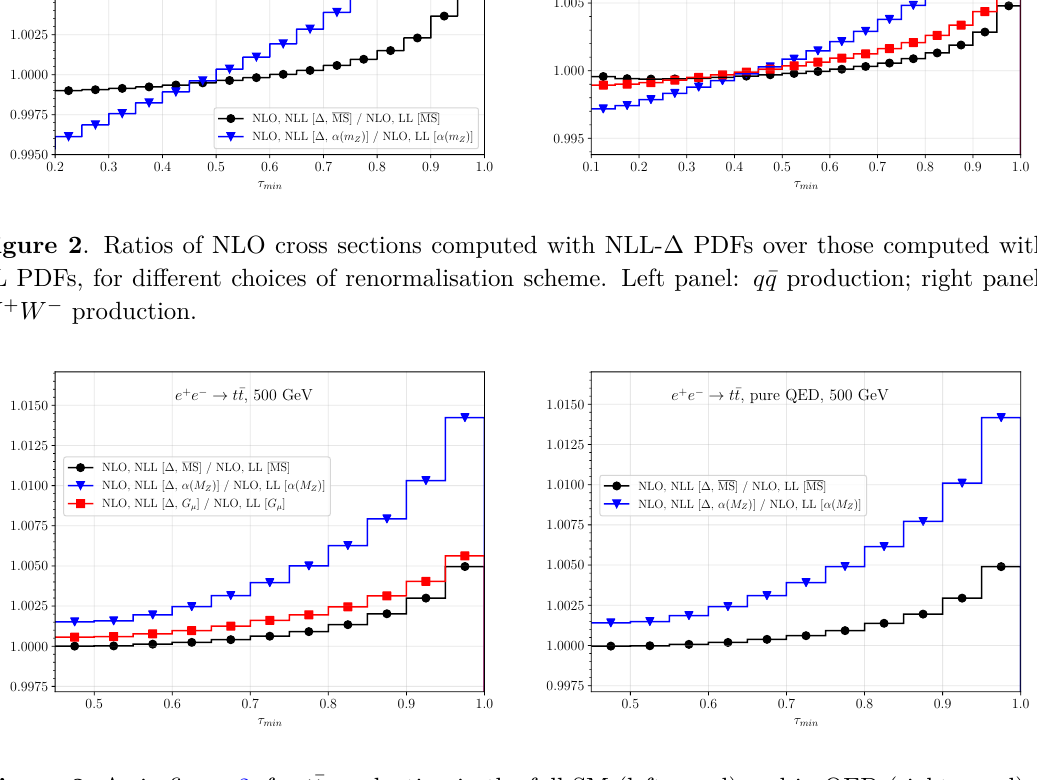
Figure 3 . As in figure 2, for t ¯ t production in the full SM (left panel) and in QED (right